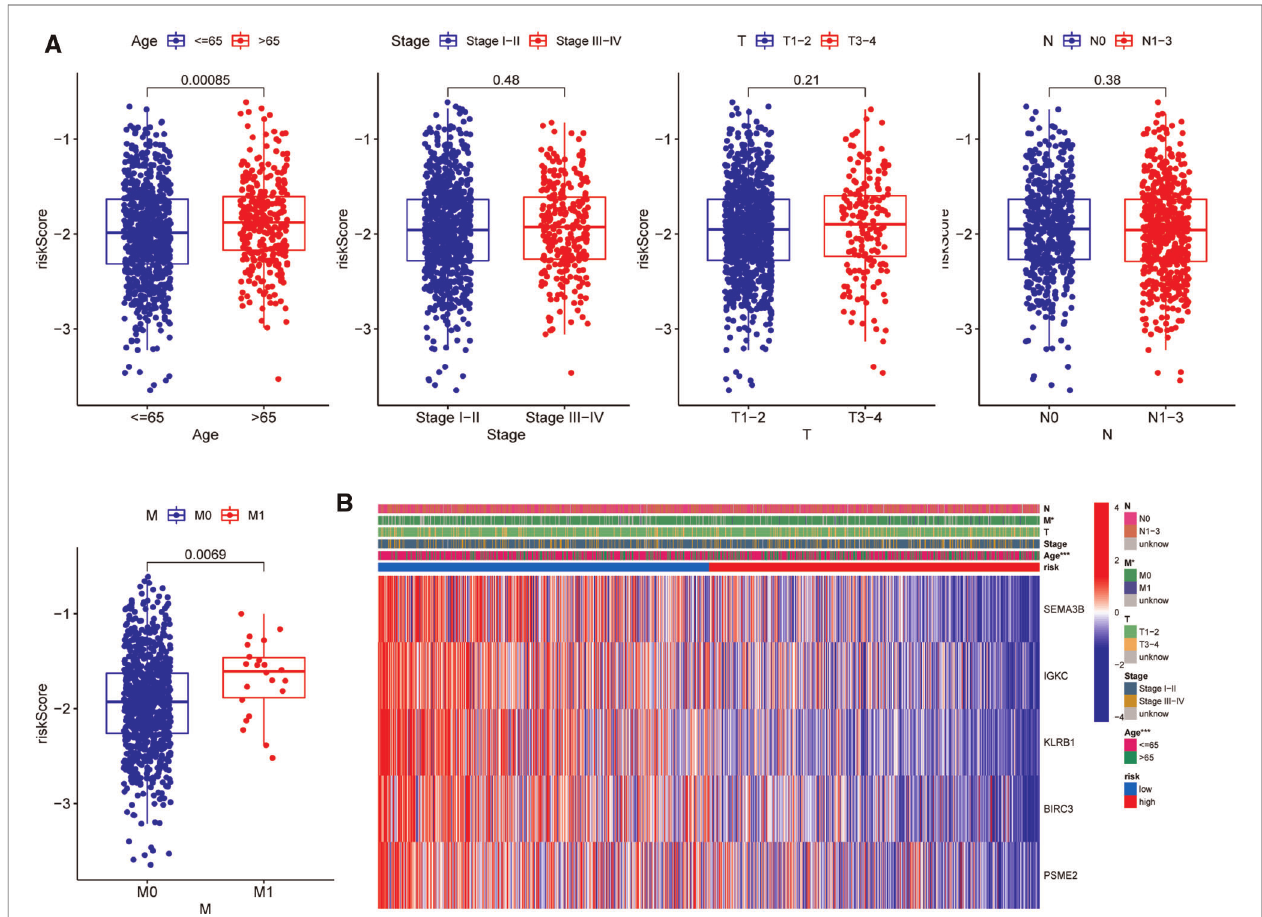
FIGURE 7 | Correlations between signature and clinicopathological parameters. ( A ) Correlations with age, clinical stage, and TNM stage. ( B ) Heatmap indicating the clinicopathologic features of the two risk subgroups. * p <0.05, ** p <0.01, *** p <0.001, ns, not signi fi